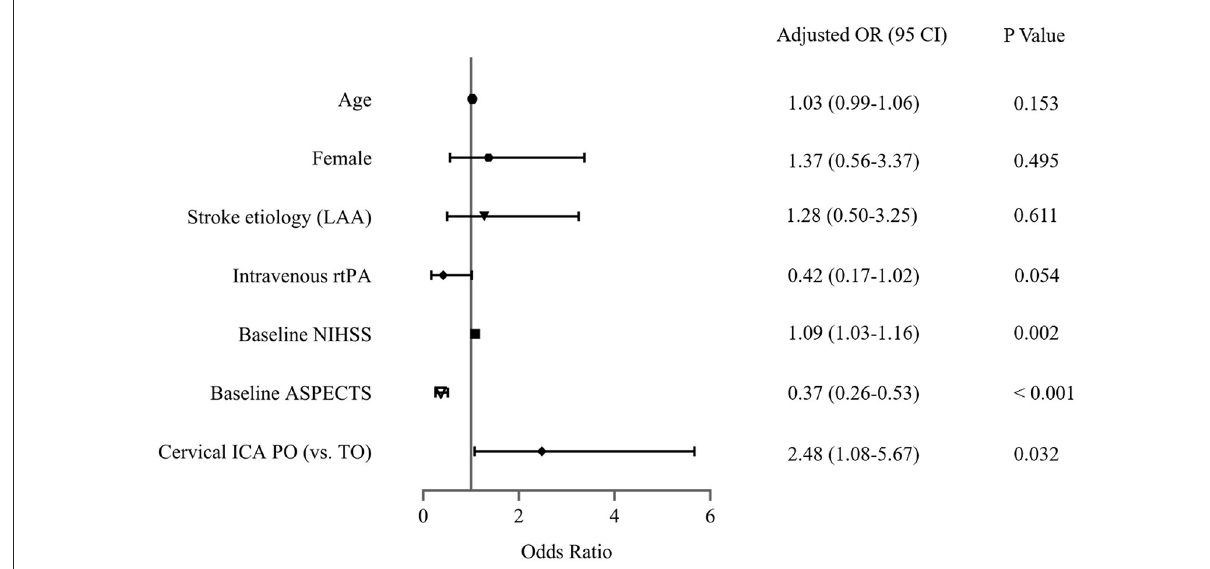
FIGURE4 Assessment of association between cervical internal carotid artery (ICA) pseudo-occlusion (PO) and clinical outcome in the sensitivity analysis. LAA, large arterial atherosclerosis; rtPA, recombinant tissue plasminogen activator; NIHSS, National Institutes of Health Stroke Scale; ASPECTS, Alberta Stroke Program Early CT Score; TO, true